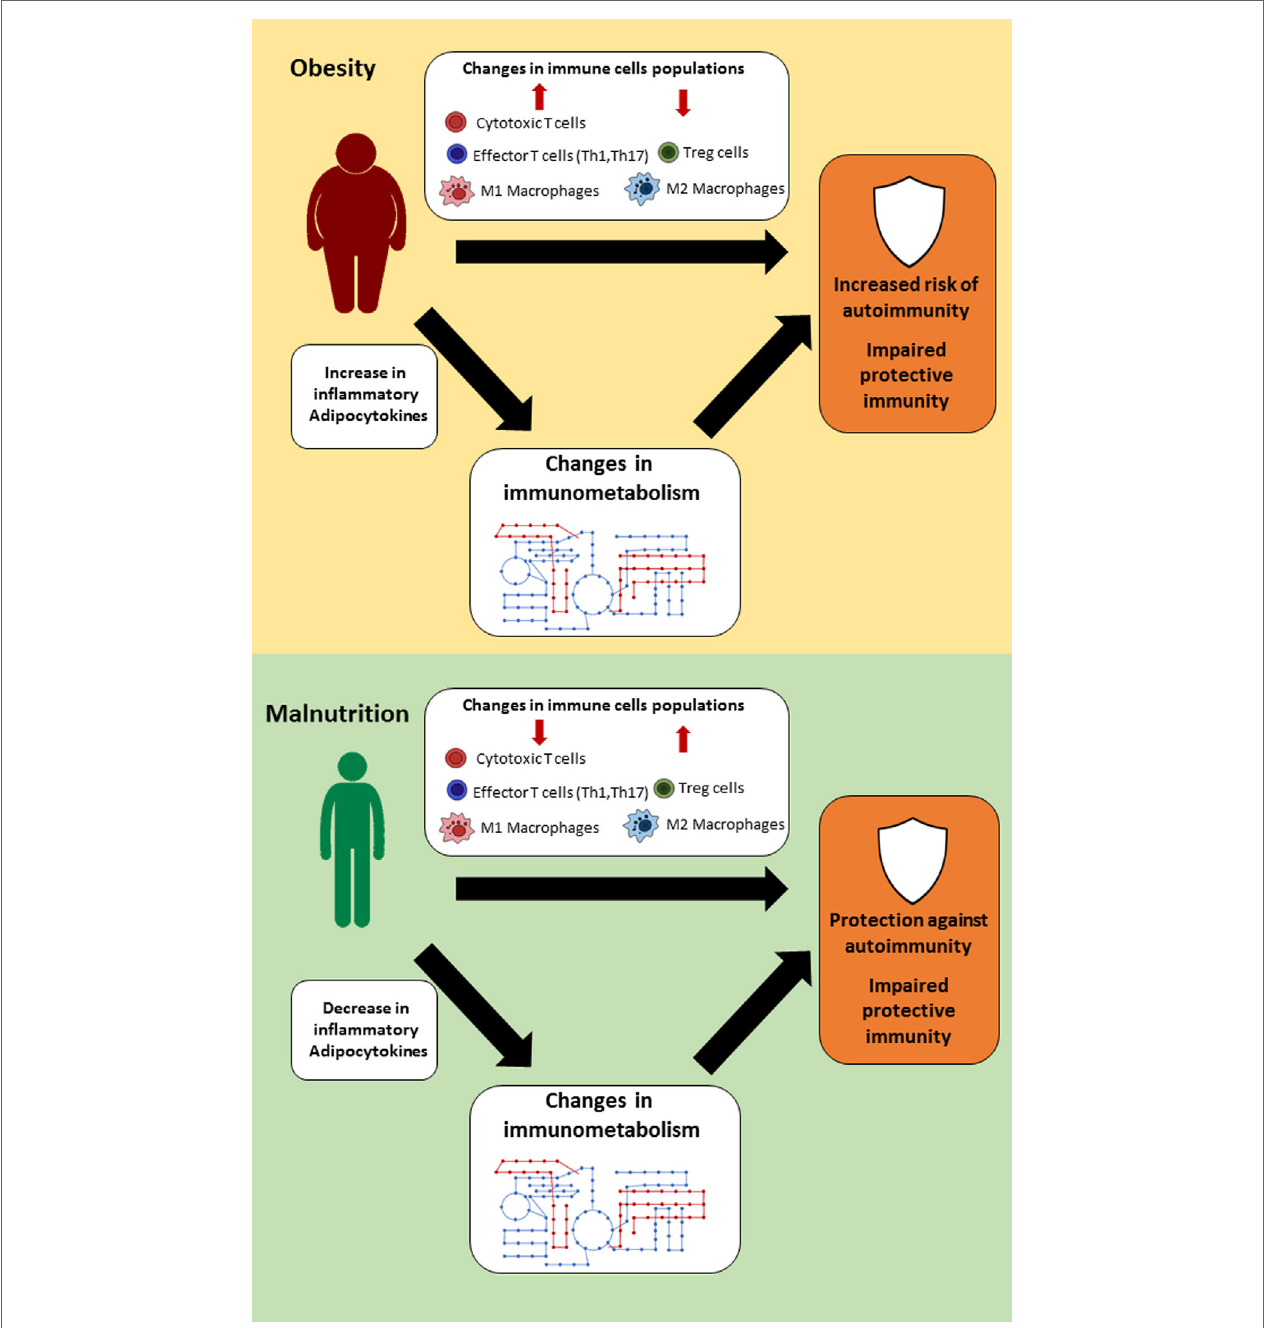
FiGURe 1 | Suggested links between nutritional status, immune metabolism, and immune function. In settings of extreme nutritional status (obesity or malnutrition), changes in immune cell populations, hormones, and cytokine levels lead to alternations in immune cell metabolism, which thereby influence immune